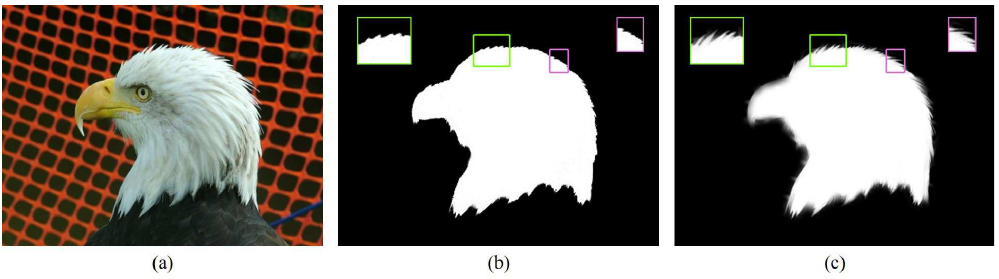
Figure 1. Edge-preserving filtering results of a binary image using local guided filter. ( a ) is the guide image. ( b ) is the input image. ( c ) is the guided filter